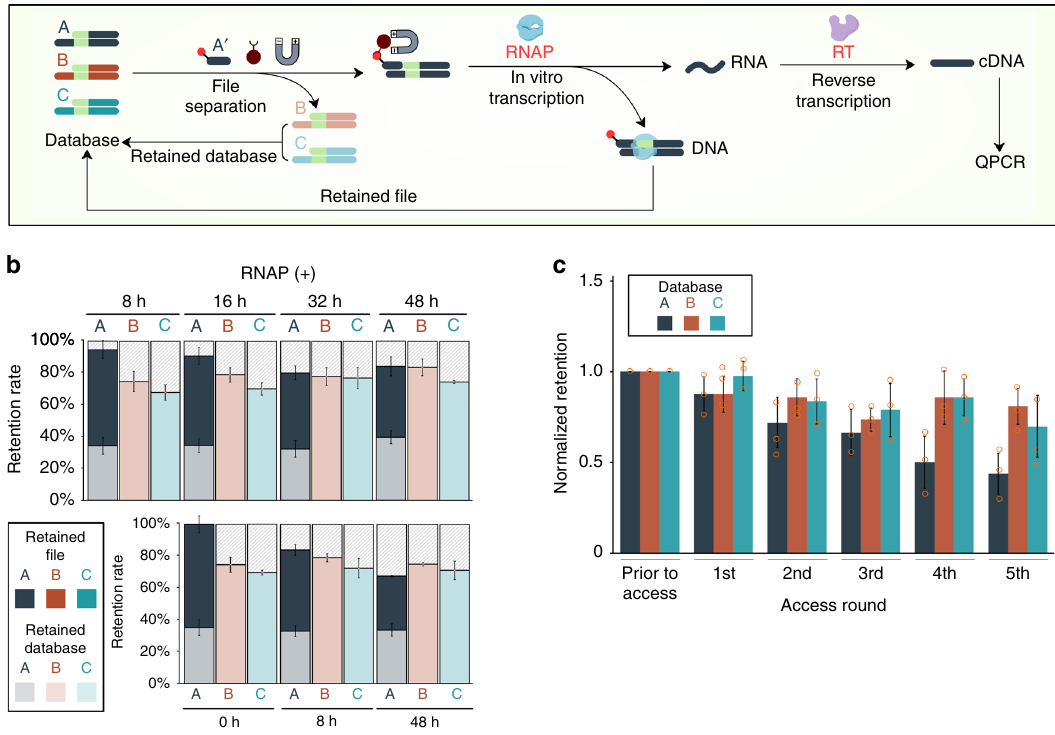
Fig. 3 DORIS mimics natural transcription to repeatedly access information. a File A was separated using non-PCR-based magnetic separation while the database was recovered (Retained Database) ( n = 3 for each condition). T7-based in vitro transcription was performed directly on the bead-immobilized fi le for up to 48 h to generate RNA. Reverse transcription converted the RNA to complementary DNA (cDNA) while the immobilized fi le A was released back into the database (Retained File) ( n = 3 for each condition). b The amount of retained database (light shading) and retained fi le (dark shading) after fi le A was accessed by oligo A ’ was measured by qPCR and plotted as a percentage of the original amount of each fi le that was in the database. The speci fi city of fi le access is evident by the absence of fi le B and C in the Retained File. The presence of T7 RNA polymerase (RNAP) did not affect the retention of fi le A. c File A was repeatedly accessed 5 times. The amounts of fi le A, B and C in the database were measured by qPCR and plotted as the amount of each fi le in the database after each run ( n = 3 for each condition), normalized to the original amount of each fi le prior to the 1st access. Values represent the arithmetic mean. Error bars are s.d., n = the number of replicate fi le accesses. Source data are provided as a Source Data fi